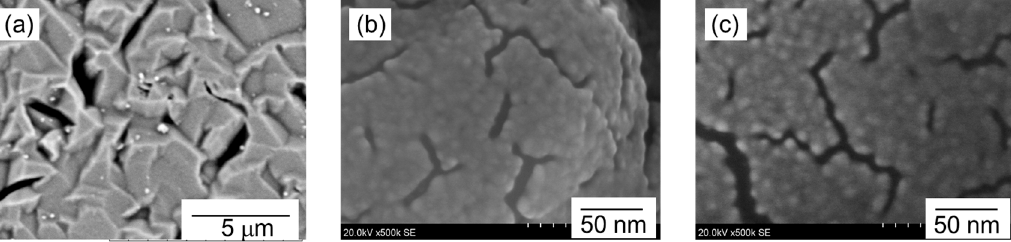
Figure 4. SEM images of the resonator surface coated with PNIPAM nanoparticles; ( a ) low magnification ( × 10 k); ( b ) high magnification ( × 500 k) of the nanoparticle observed in ( a ); ( c ) high magnification ( × 500 k) in the region where nanoparticles were not observed in ( a